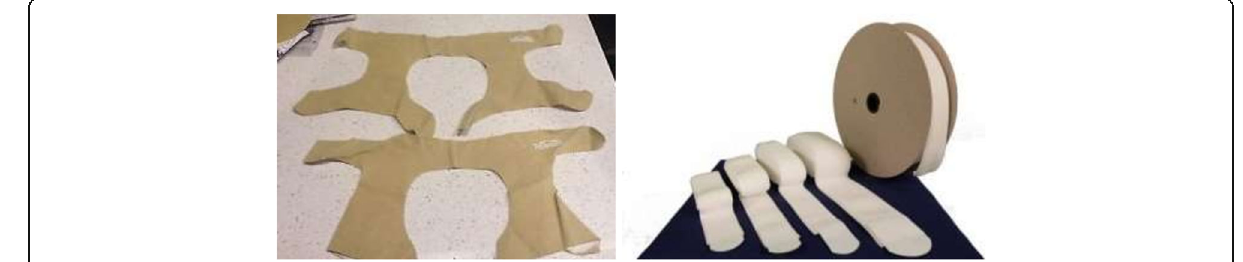
Fig. 4 TheraTogs Orthotic undergarment and strapping